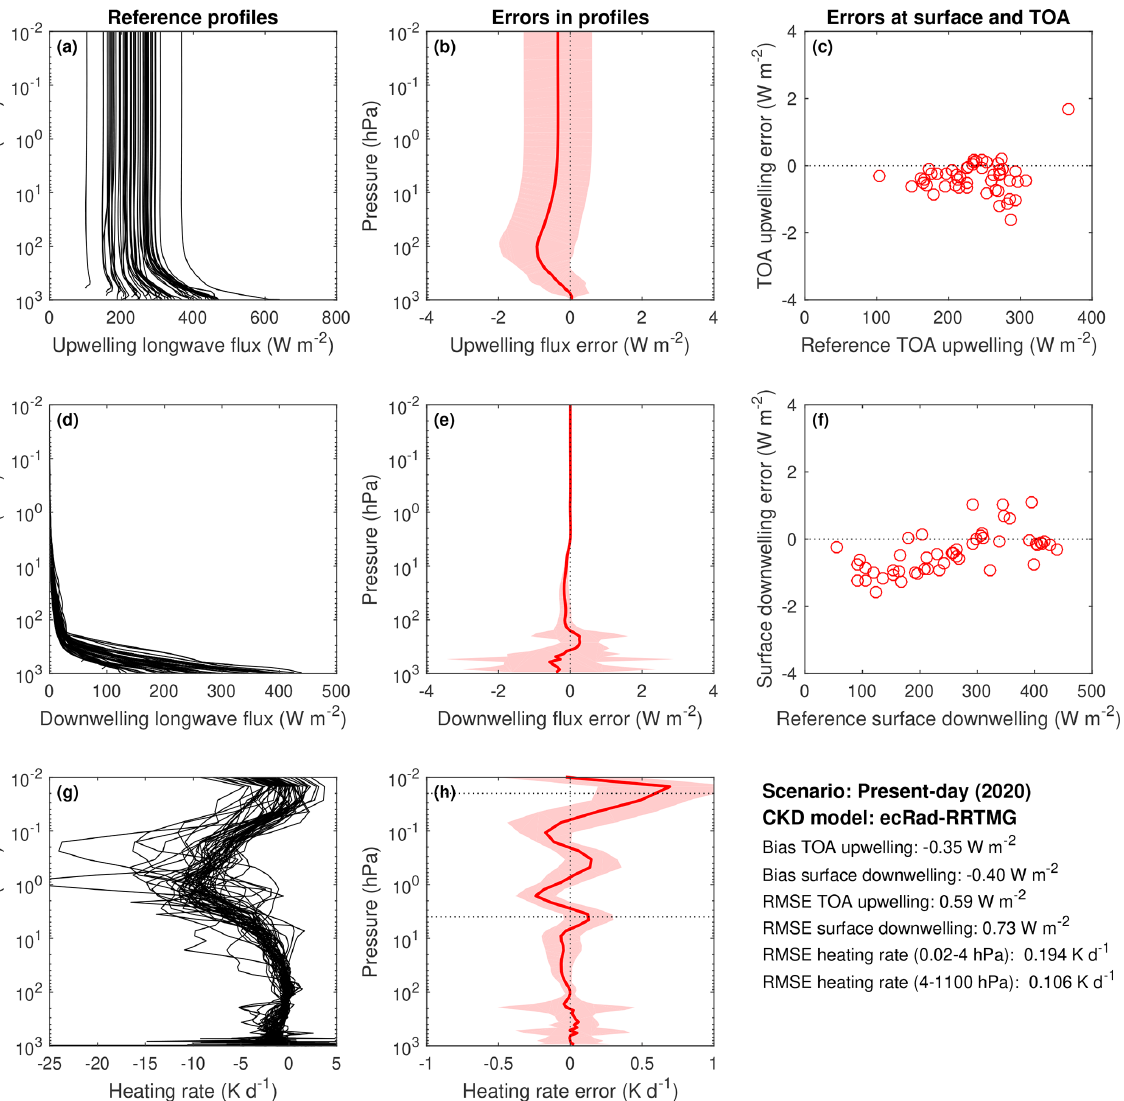
Figure 5. Evaluation of longwave irradiances and heating rates from the RRTMG CKD model for the 50 profiles of the Evaluation-1 dataset with present-day concentrations of the well-mixed greenhouse gases: panels (a, d, g) show the upwelling and downwelling irradiances and heating rates from the reference LBL calculations. The red lines in panels (b, e, h) show the corresponding bias in the calculation of these quantities from RRTMG. The shaded regions encompass 95% of the errors in the instantaneous profiles (estimated as 1.96 multiplied by the standard deviation of the error). Panels (c, f) depict instantaneous errors in upwelling TOA and downwelling surface irradiances. The statistics of the comparison are summarized in the lower right, including the root-mean-squared error (RMSE) in heating rate (weighted by the cube root of pressure) in two ranges of pressure indicated by the horizontal dotted lines in panel (h)